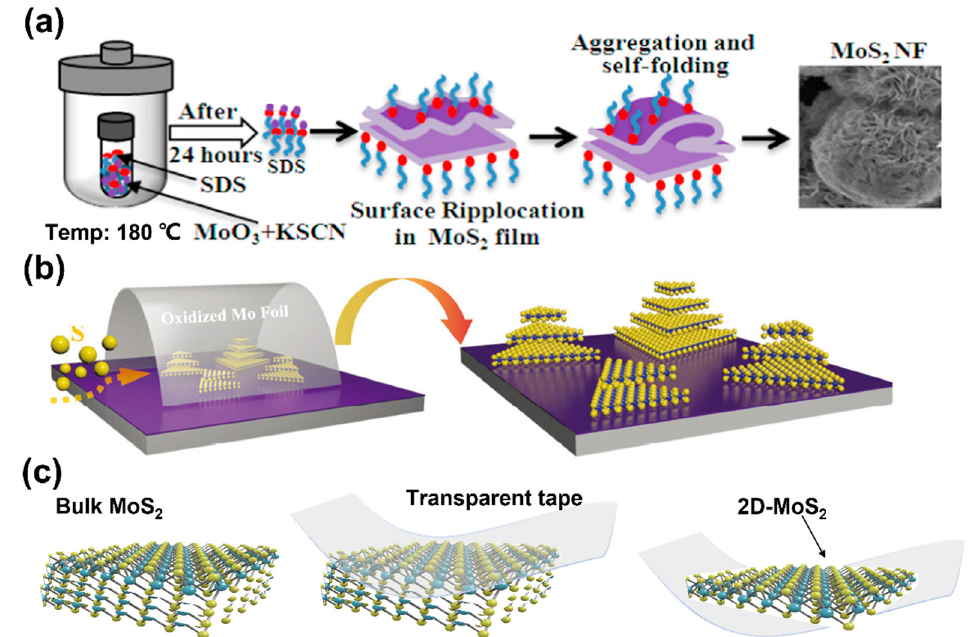
Figure 3. ( a ) Schematic of hydrothermal method to fabricate MoS 2 nanoflowers. Reprinted with